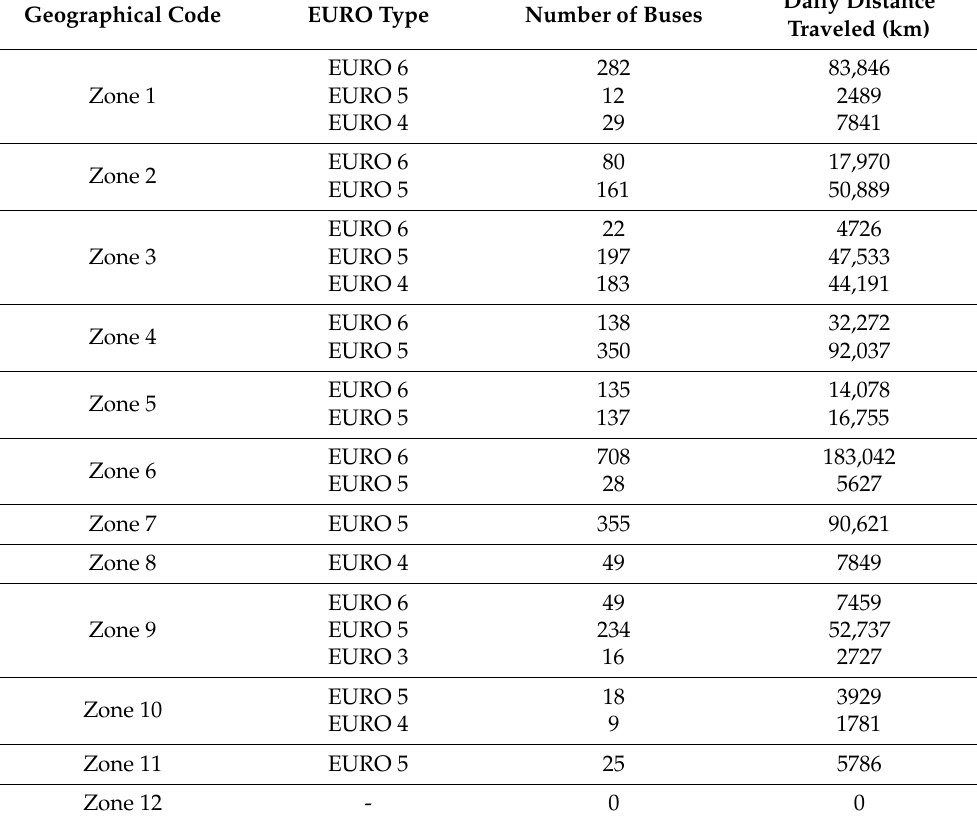
Table A1. Public Buses Data by